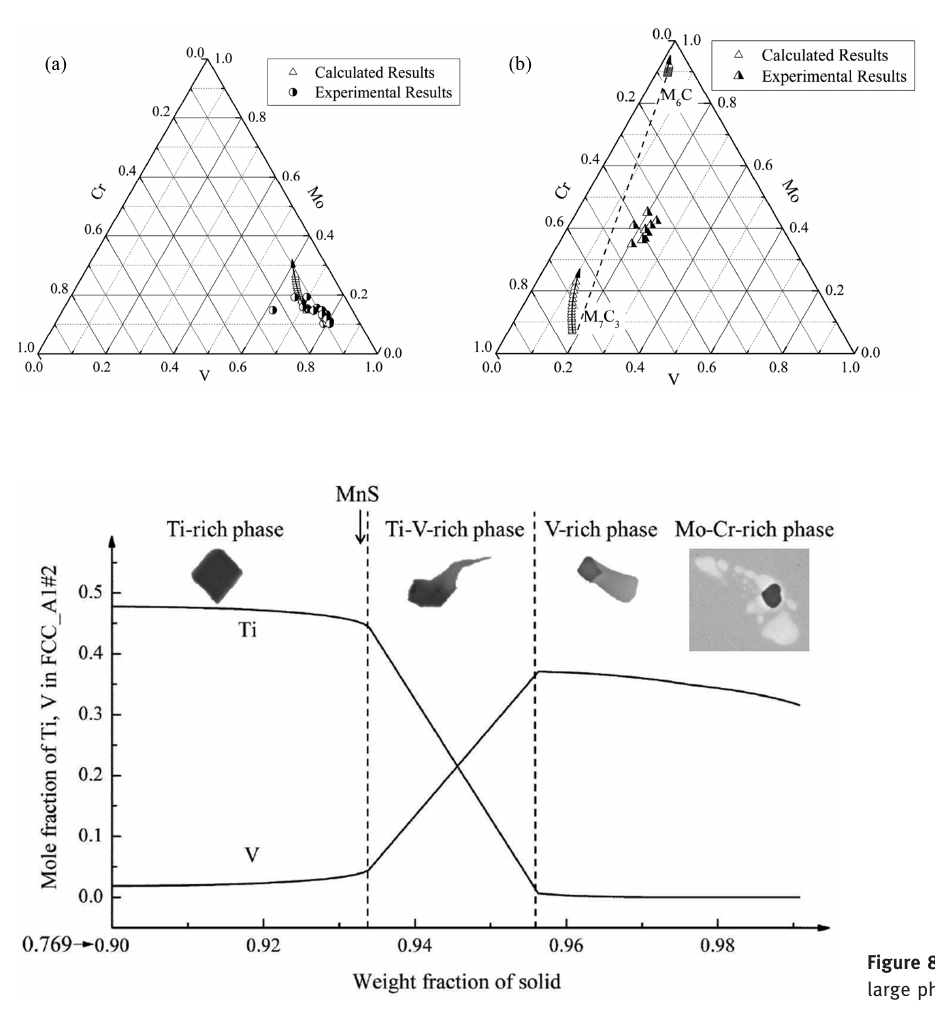
circle) are plotted in Figure 7(b). The curve with an arrow represents the compositional changing direction.